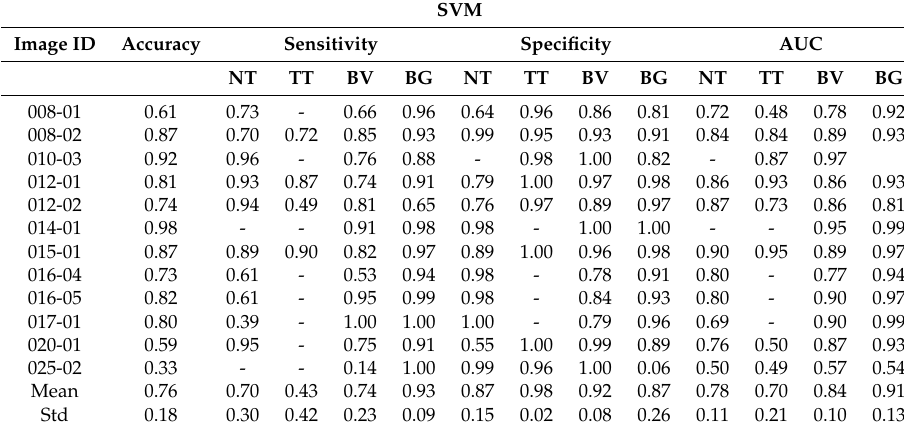
Table A3. Overall results for the SVM model. Accuracy, sensitivity, specificity, and AUC are calculated for each class. NT: Normal tissue, TT: Tumor tissue, BV: blood vessels, BG: Background.